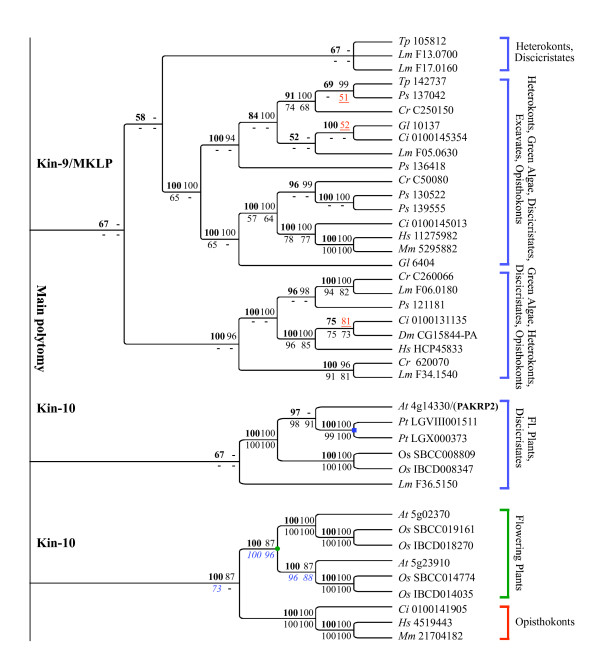
Expanded view of Kinesin-9 and Kinesin-10 families. Expansion of the Kinesin-9 and Kinesin-10 families from Fig. 2. An experimentally studied Arabidopsis kinesin is indicated in parenthesis with its published name in bold. Green brackets indicate plant-specific groups, mixed clades are shown in blue brackets and red brackets indicate groupings composed of opisthokonts. Green circle and blue square indicate gene duplications in flowering plants and dicots, respectively. See Fig. 2 legend for an explanation of support values. Support values in italicized blue font indicate those clades supported in the parsimony analyses except for the inclusion of Pt 00151235 (see text). For full names of species see Fig. 1 legend. Fl. Plants, flowering plants.